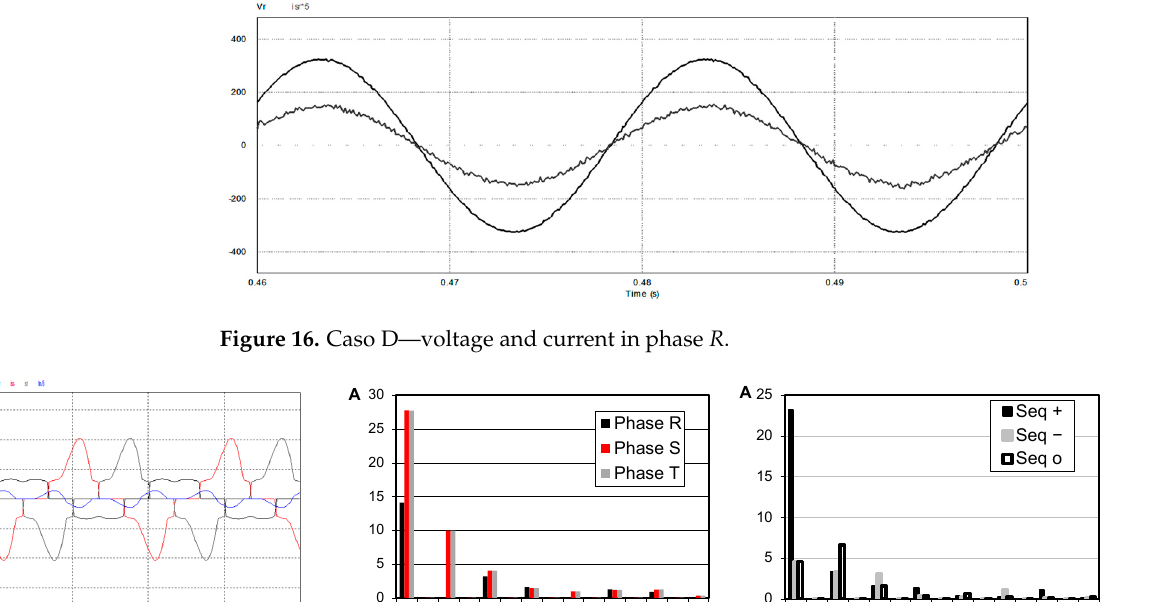
Figure 16. Caso D - voltage and current in phase R .